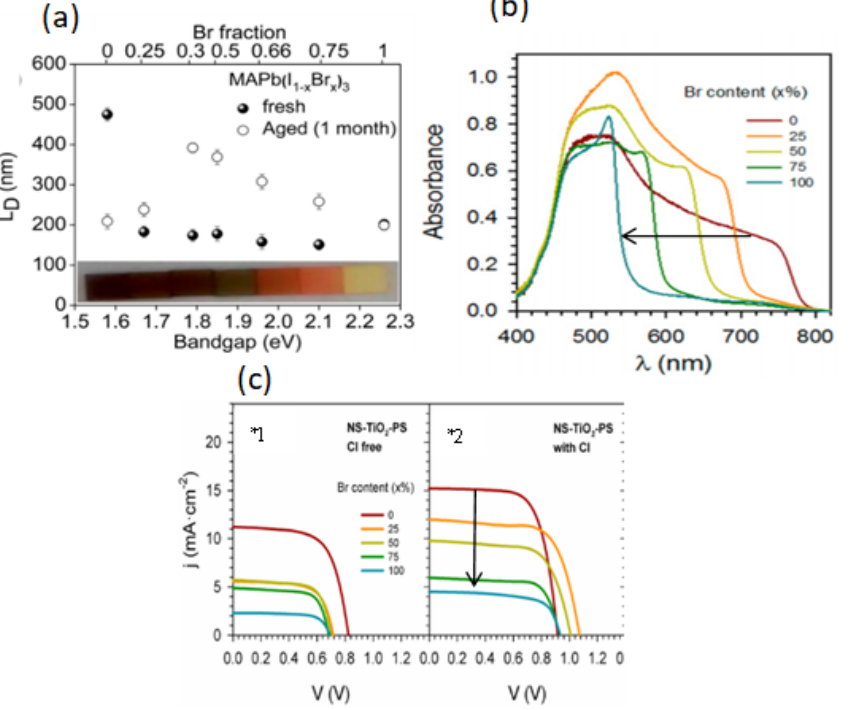
Figure 7. ( a ) A plot of diffusion length (L nm) against bandgap energies of aged and non-aged MAPb(I 1-x Br x ) 3 perovskite thin films. ( b ) Absorption spectra of mixed-halide perovskite film. ( c ) I–V curve in a hybrid mixed-halide PSC [28,47].